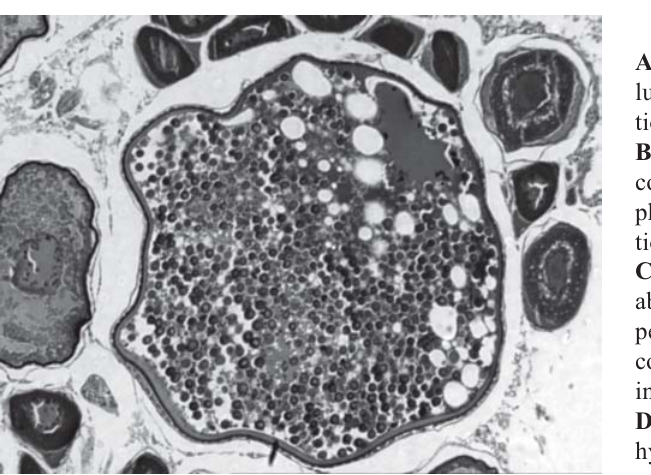
Fig. 9. Merluccius hubbsi: atresic follicle (arrow) (1.5mm length